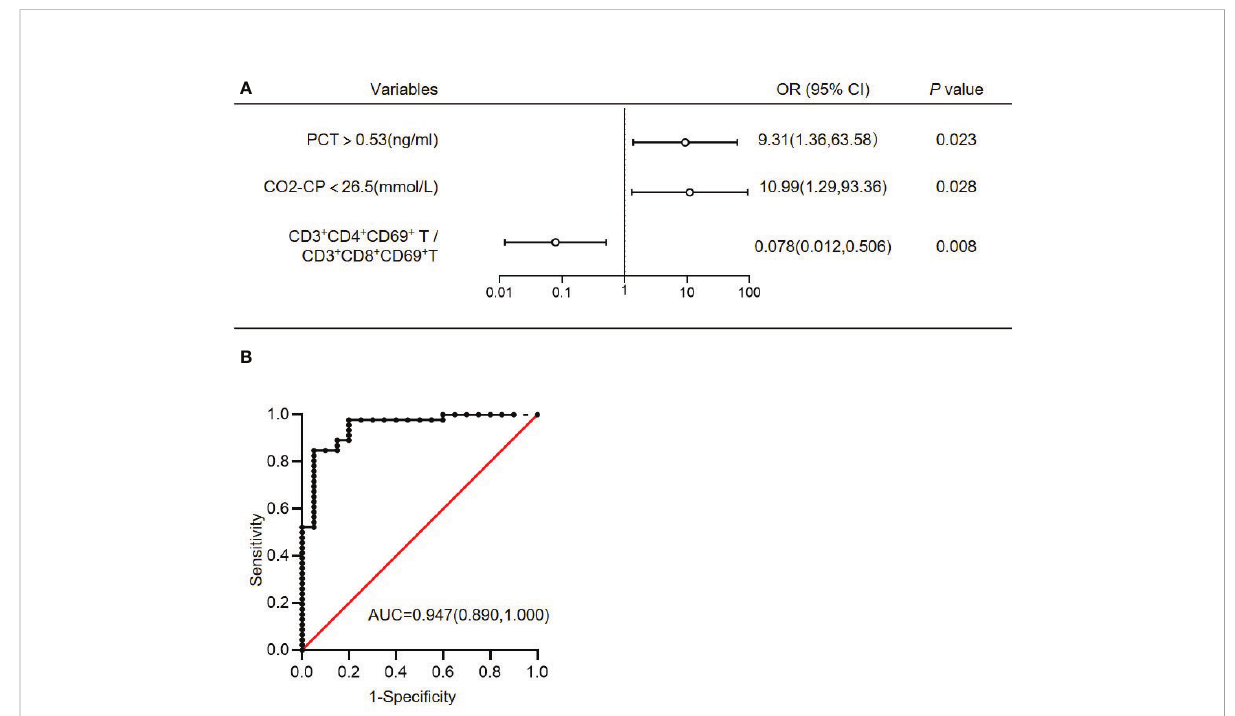
FIGURE 3 Multivariate logistic regression analysis of G - bacterial sepsis (versus G + bacterial sepsis). (A) Multivariate logistic regression analysis of G - bacterial sepsis (versus G + bacterial sepsis). (B) ROC curve of the multivariate logistic regression model. AUC, area under the ROC curve; OR, odds ratio; 95%CI, 95% con fi dence interval; CO 2 CP, carbon dioxide combining power; PCT,